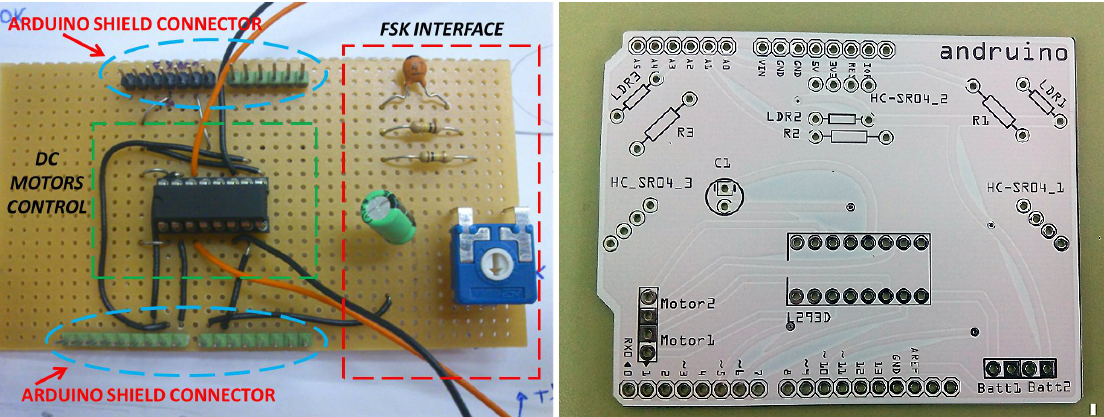
Figure 3. Andruino-A1 shield ( left ) and new Andruino-R2 shield ( right